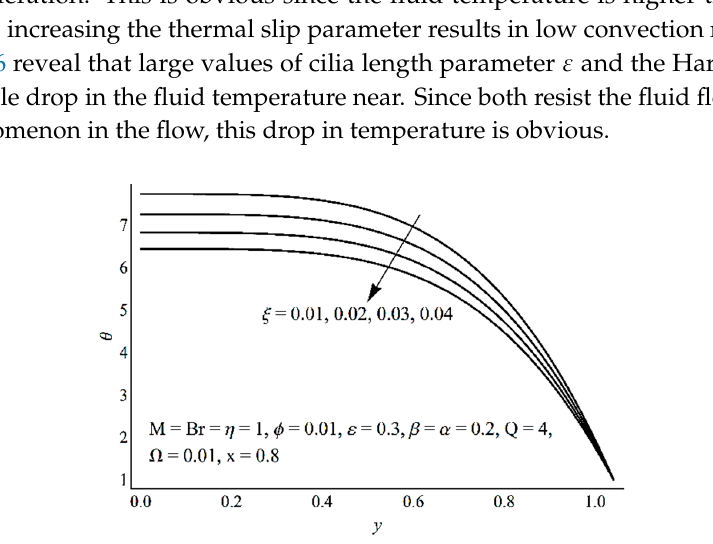
Figure 13. The temperature profile against various values of velocity slip parameter ξ .